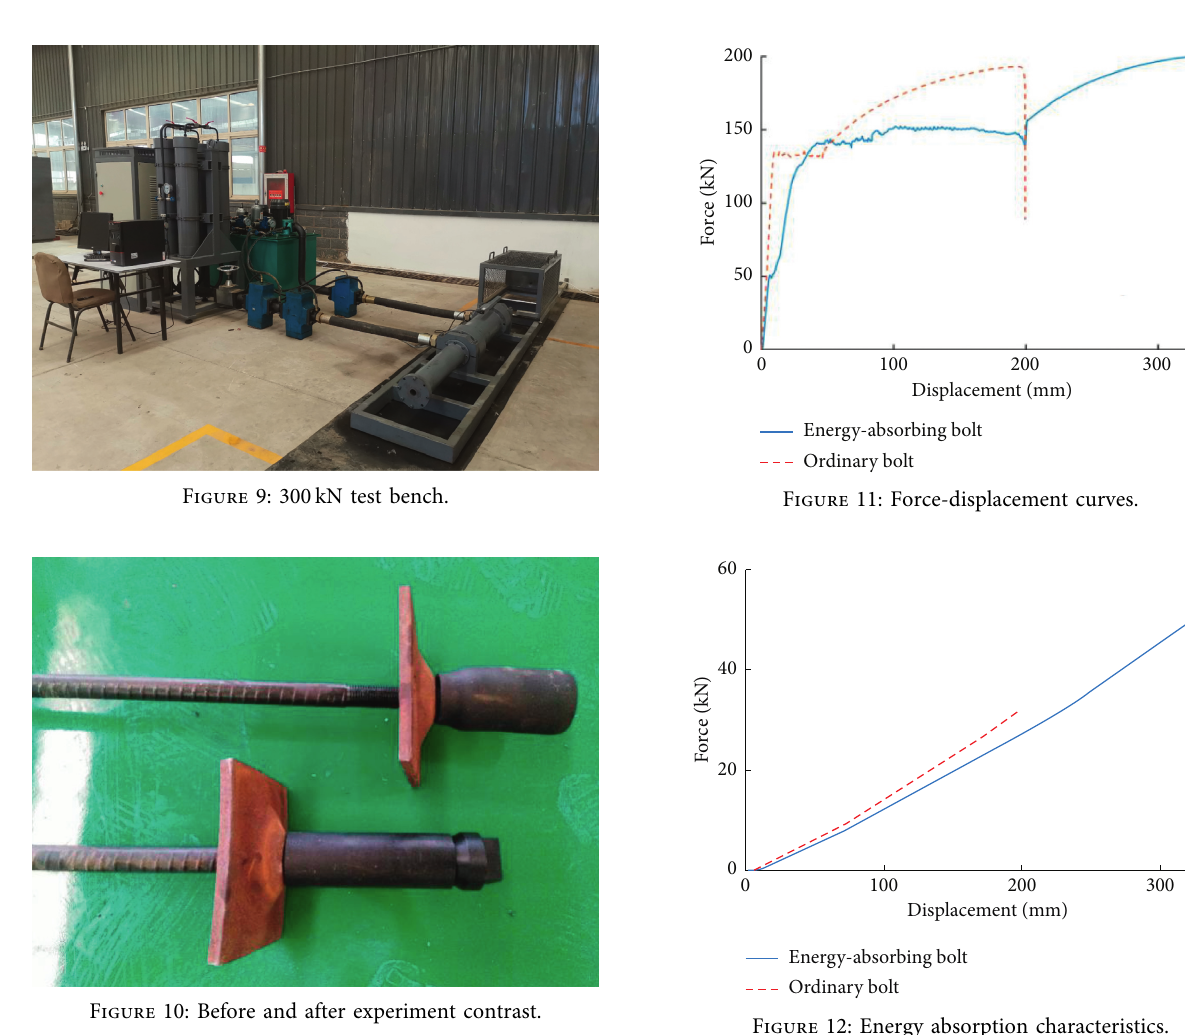
Figure 8: 600kN test bench.